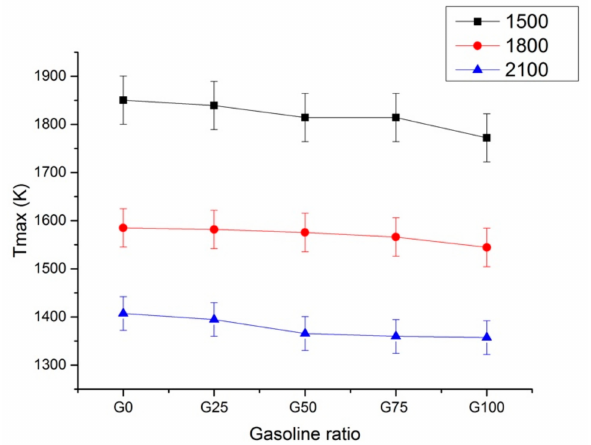
Figure 5. Peak in-cylinder temperature with R e for di ff erent speed (The direct injection timing is 180 ◦ CA BTDC. The ignition timing is MBT. The intake manifold absolute pressure is 42